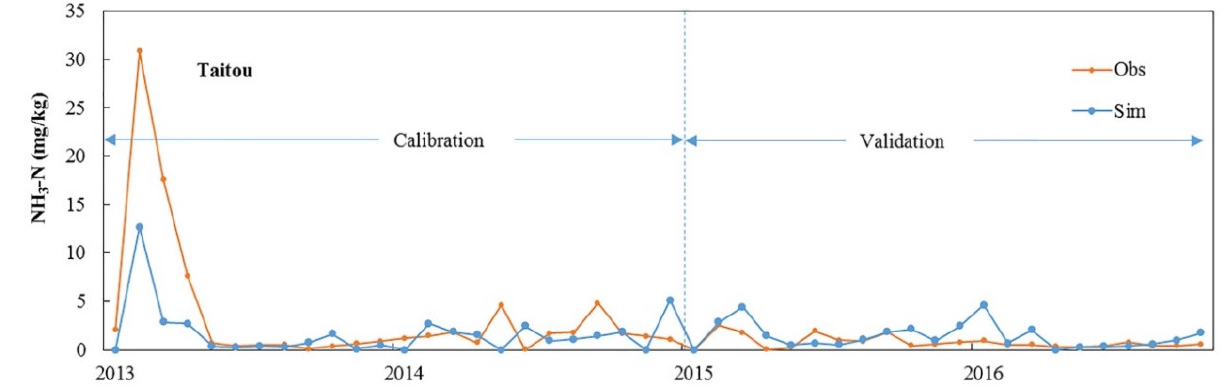
Figure 5. Measured and simulated values of NH 3 -N (Taitou Station).